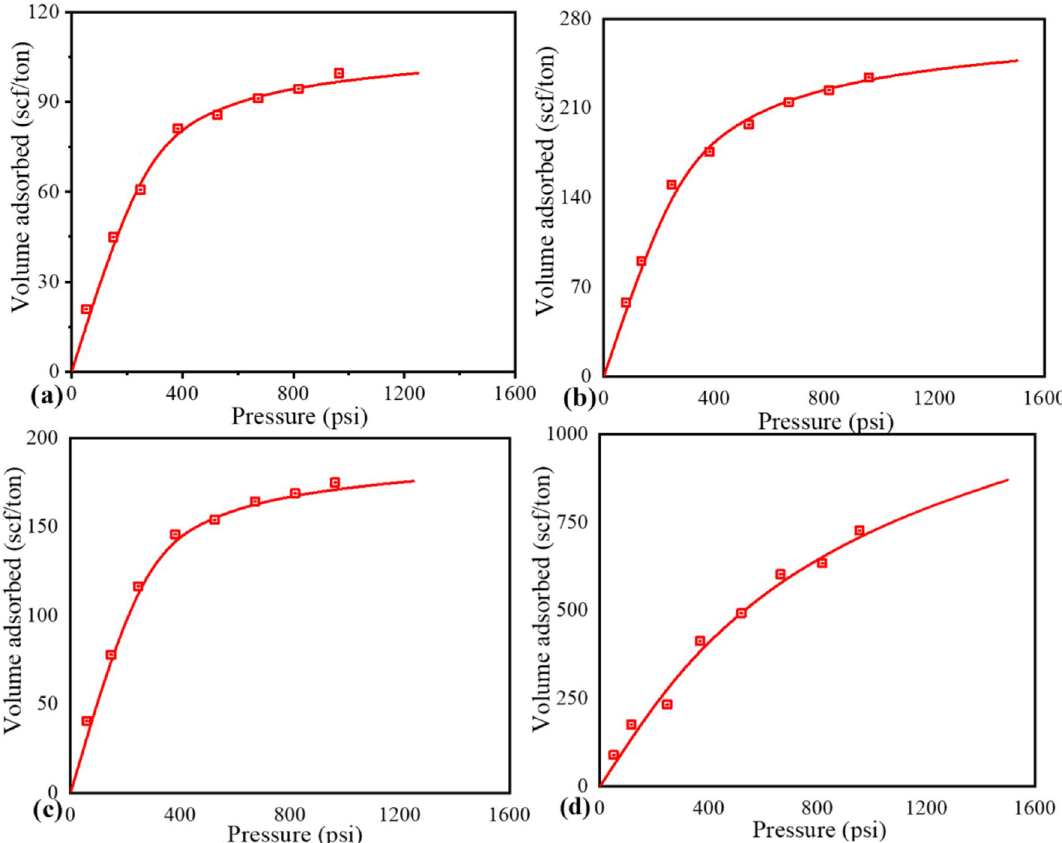
Figure 5. The CBM adsorption isotherms of the coal samples: ( a ) G.C. #1 ( b ) G.C. #5 ( c ) G.C. #7 ( d ) G.C.